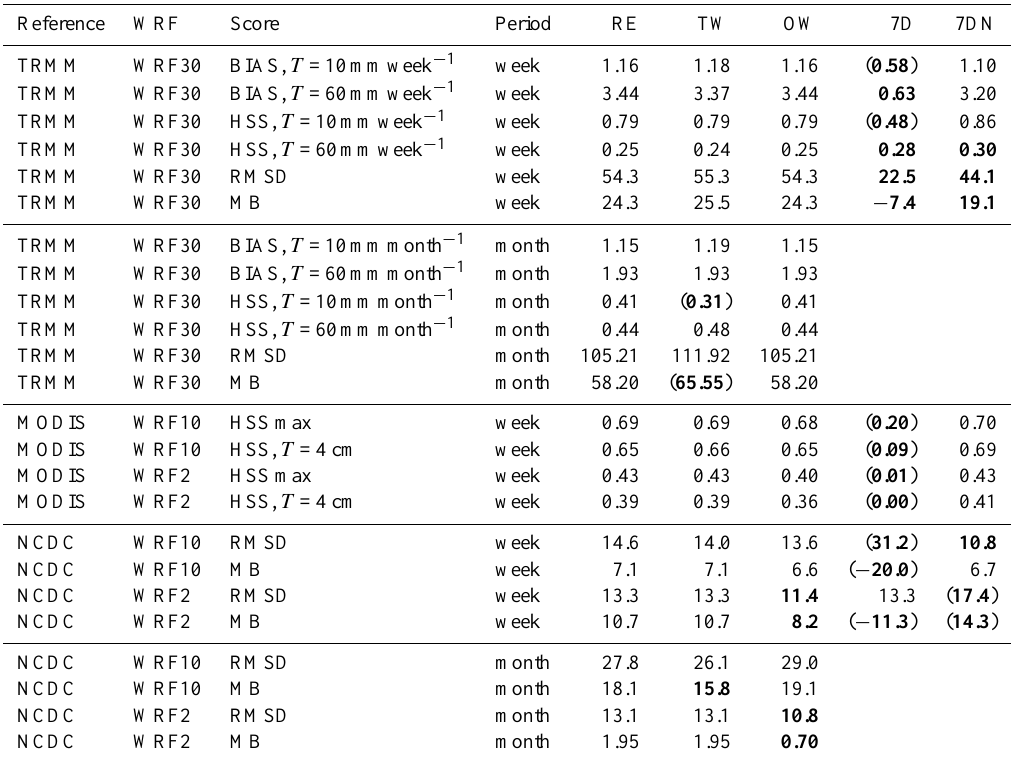
Table 5. Scores used for statistical evaluation of the reference, nesting and forcing experiments. The scores that differ of more than 10% from the RE are marked in bold, and put between parentheses if they have a lower skill than the